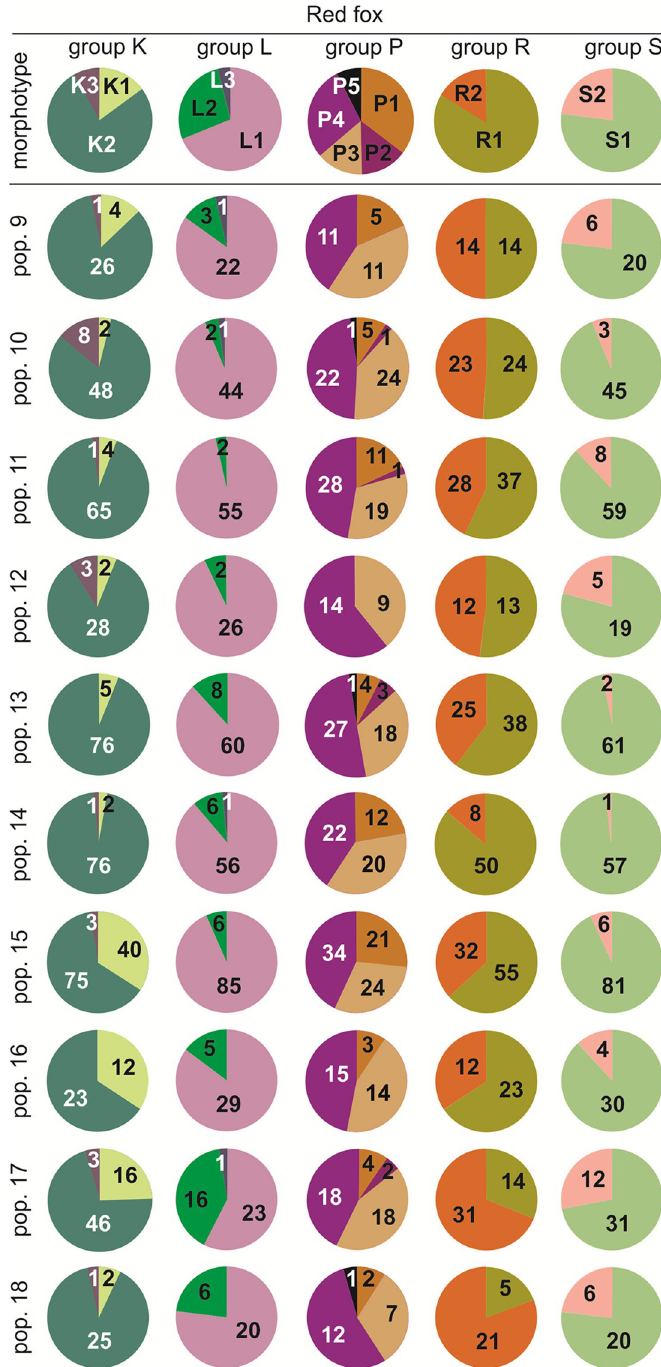
Fig 4. Share of morphotypes in fossil and recent populations of the red fox. Numerals in each part of the pie chart are the numbers of specimens with the morphotypes. Illustrations of the tooth variants and morphotypes are shown in Fig 2. Information about the samples can be found in Table